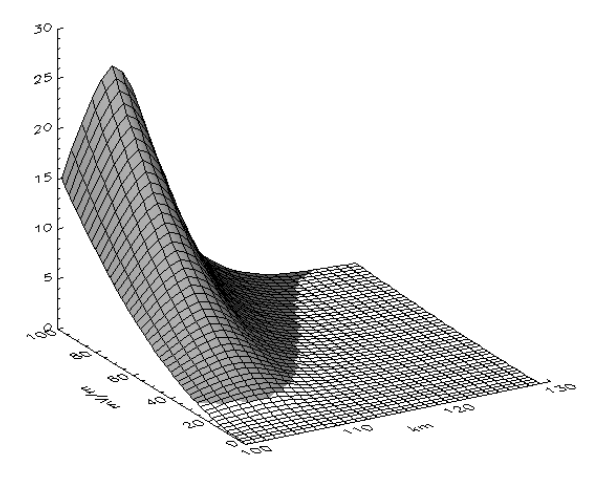
Fig. 3. The proposed analogy to the Reynolds number as a function of height and electric field strength, for summer conditions. The shaded area indicates where the metric exceeds